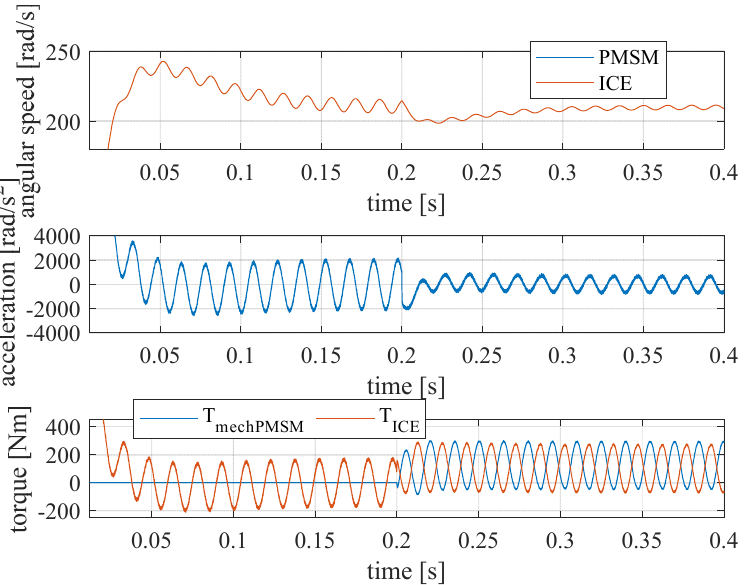
Figure 23. Speed and torques during parallel cooperation and compensation oscillating torques.